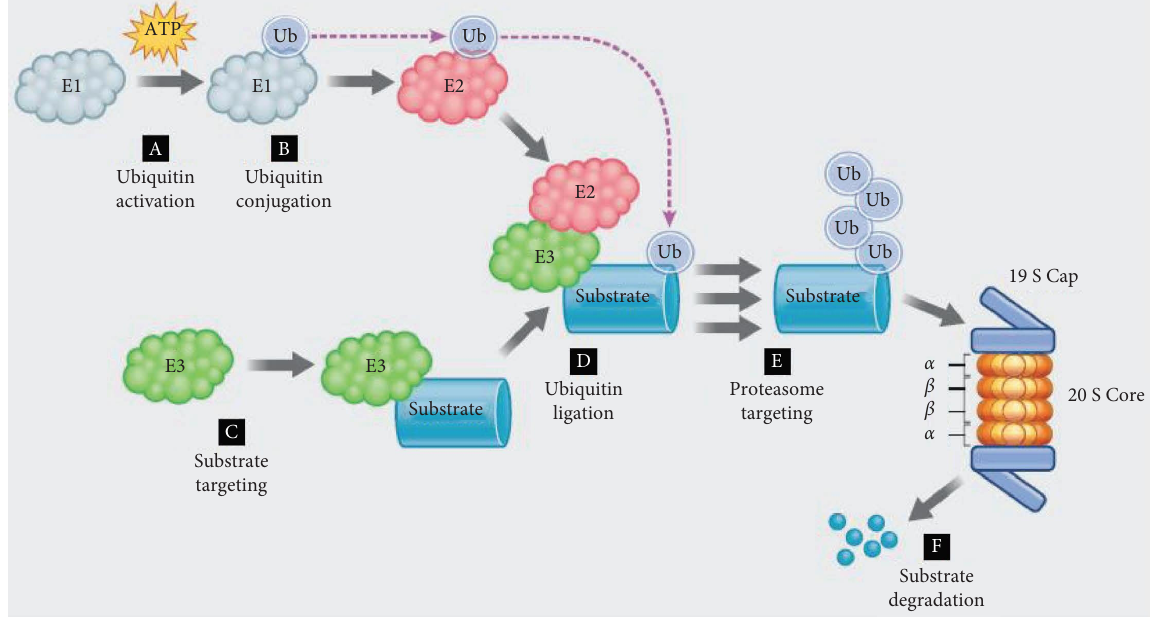
Figure 2: (a) In the presence of ATP, ubiquitin is activated and attached to E1; (b) ubiquitin is conjugated to E2; (c) E3 targets proteins that are intended for destruction; (d) ubiquitin is ligated to the protein substrate; (e) repeated ubiquitin ligation aims the substrate at the proteasome; (f) the 19S cap of the proteasome recognizes the substrate, which is then broken down after entering the 20S core